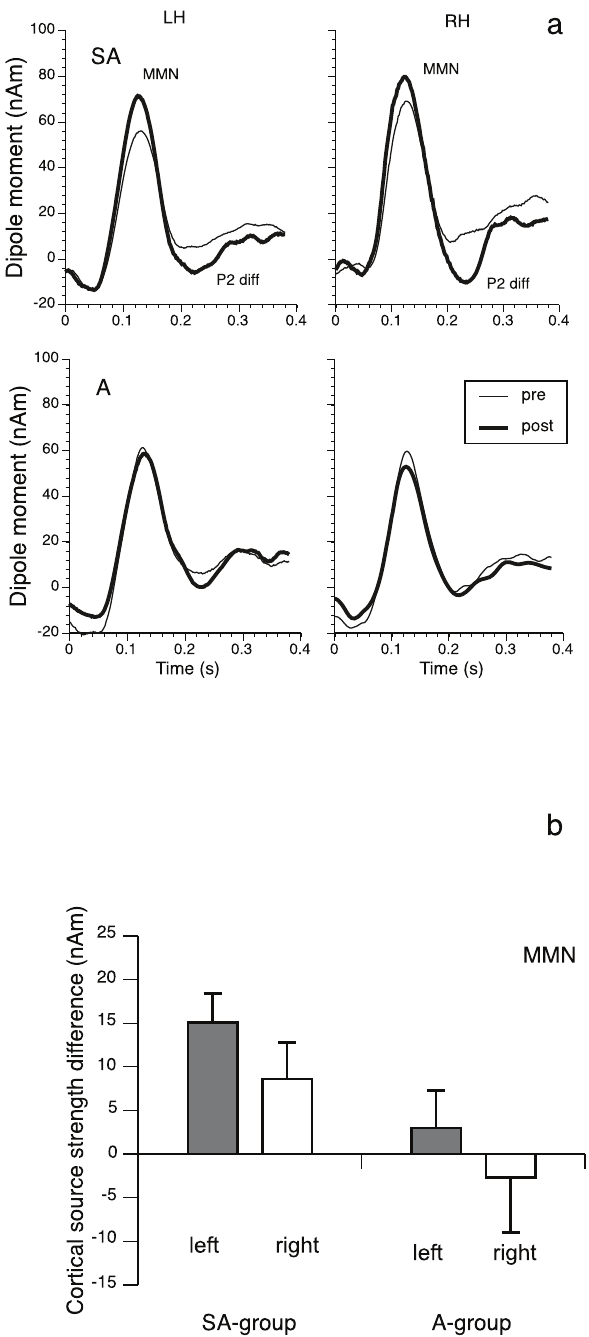
Figure 3. MMN results. (a) Group averages of the source waveforms obtained after performing source-space projection before and after training for both groups and hemispheres. Data for the SA-group are shown in the upper row, data for the A-group are shown in the bottom row. Data from the left hemisphere (LH) are presented on the left and those of the right hemisphere (RH) are presented on the right. Thin lines indicate pretraining and thick lines posttraining data. (b) Group averages of the pretraining/posttraining differences of the individual MMN source waveform peak amplitudes from both groups and hemispheres. Left: left hemisphere; right: right hemisphere; seq: sequence. Error bars indicate SEM.